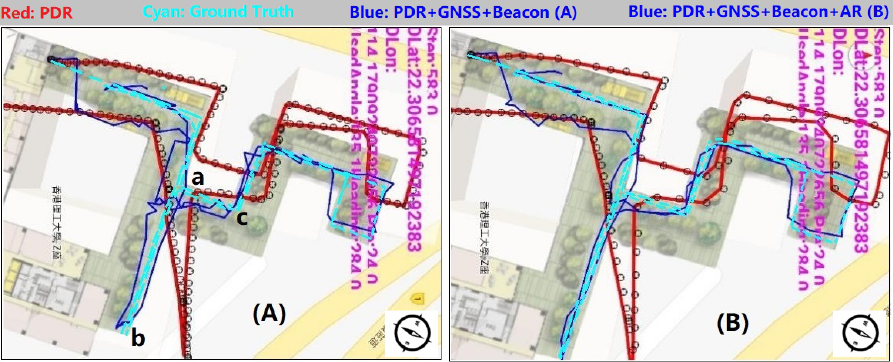
Figure 25. Graph ( A ) is the navigation test result without AR(Activity Recognition); ( B ) uses AR. In Figure 25, the red line and the cyan line are pure PDR results and the pedestrian walking route separately. The blue line, in Figure 25A, denotes ‘PDR + GNSS + Beacon’ fusion result; in Figure 25B, it denotes ‘PDR + GNSS + Beacon + Activity Recognition’ location results. ‘a’, ‘b’ and ‘c’ are corner points; the tester walked along ‘c-a-b’, mixing ‘walking’, ‘standing’ and ‘jogging’ activities together.